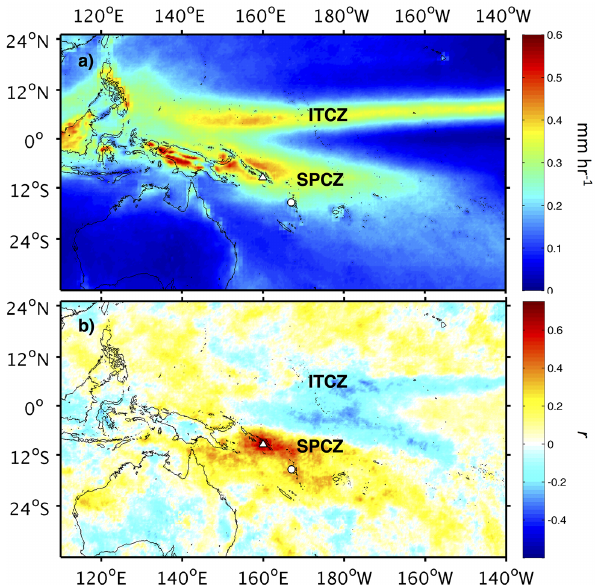
Figure 1. Tropical rainfall patterns in the Indo-Pacific (data from Kummerow et al., 2000). Bands of high rainfall are associated with the Intertropical Convergence Zone (ITCZ) and South Pacific Convergence Zone (SPCZ). (a) Annual mean surface rainfall rate (mmhr − 1 , 1998–2011). (b) Spatial correlation ( r) between monthly rainfall anomalies at Guadalcanal versus other tropical Pacific re- gions. Anomalies are relative to the 1998–2011 climatology. White triangle denotes the Guadalcanal study site; white circle denotes Espiritu Santo, Vanuatu, a location of a previously published sta- lagmite record (Partin et al., 2013).